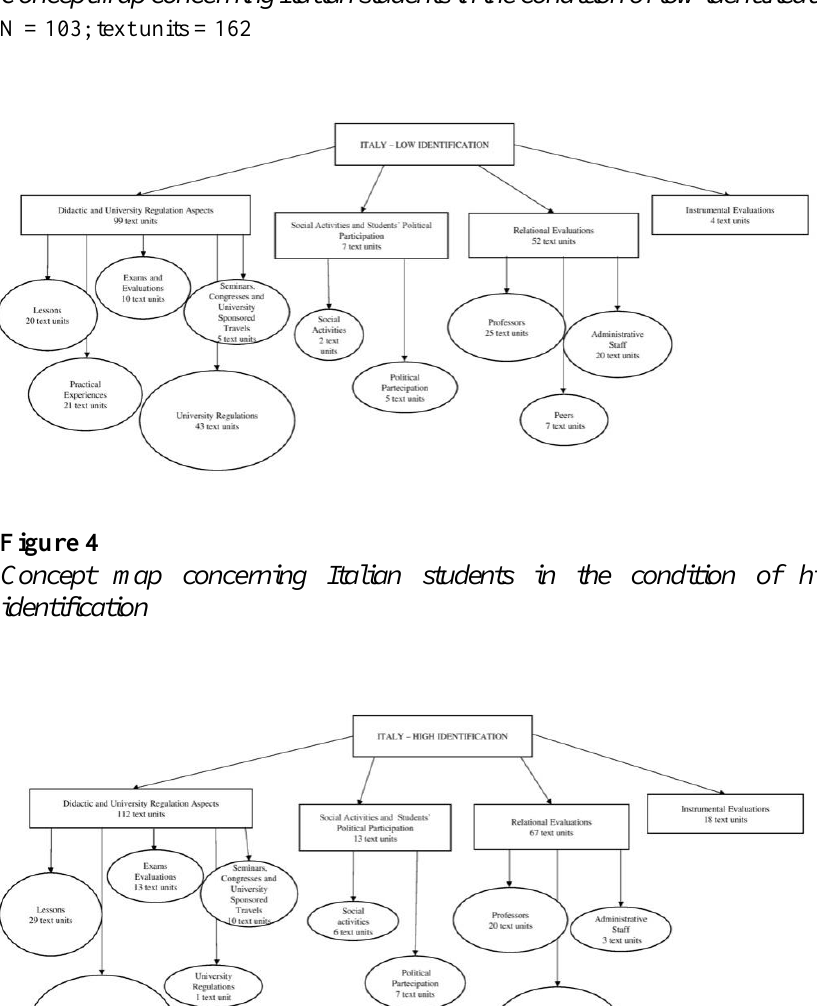
N = 108; text units =